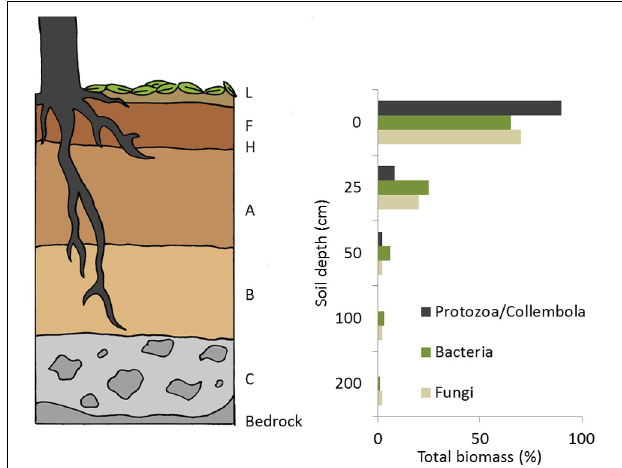
FIGURE 2 | Diagram of soil profiles with depth and the relative proportion of collembola/protozoa, bacteria and fungi at each of these depths. L, characterized by the accumulation of organic matter; F: characterized by the accumulation of partially decomposed organic matter; H: characterized by the accumulation of decomposed organic matter where the original structure is indescernable. A: mineral horizon characterized by eluviation of materials in solution, or accumulation of organic matter, or both. B: mineral horizon characterized by enrichment of clay, organic matter, and iron and aluminium oxides or by in situ weathering. C: mineral horizon characterized by little or no alteration through the soil-forming processes, usually represents the parent